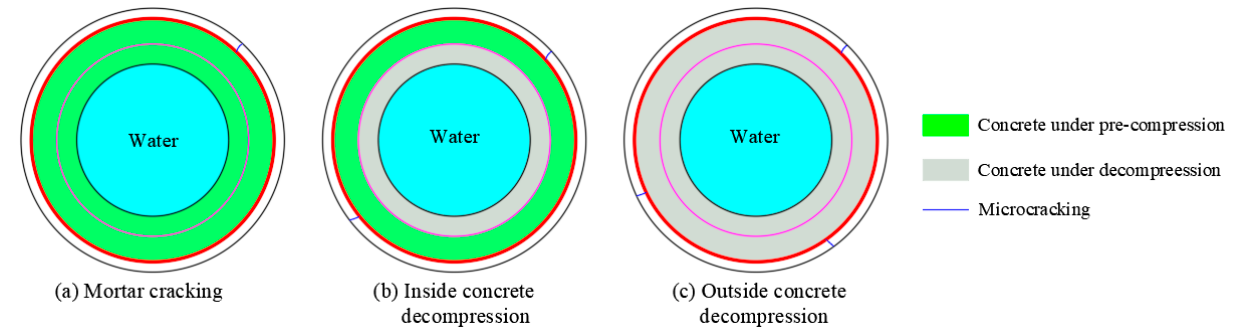
Figure 16. Decompression stage.